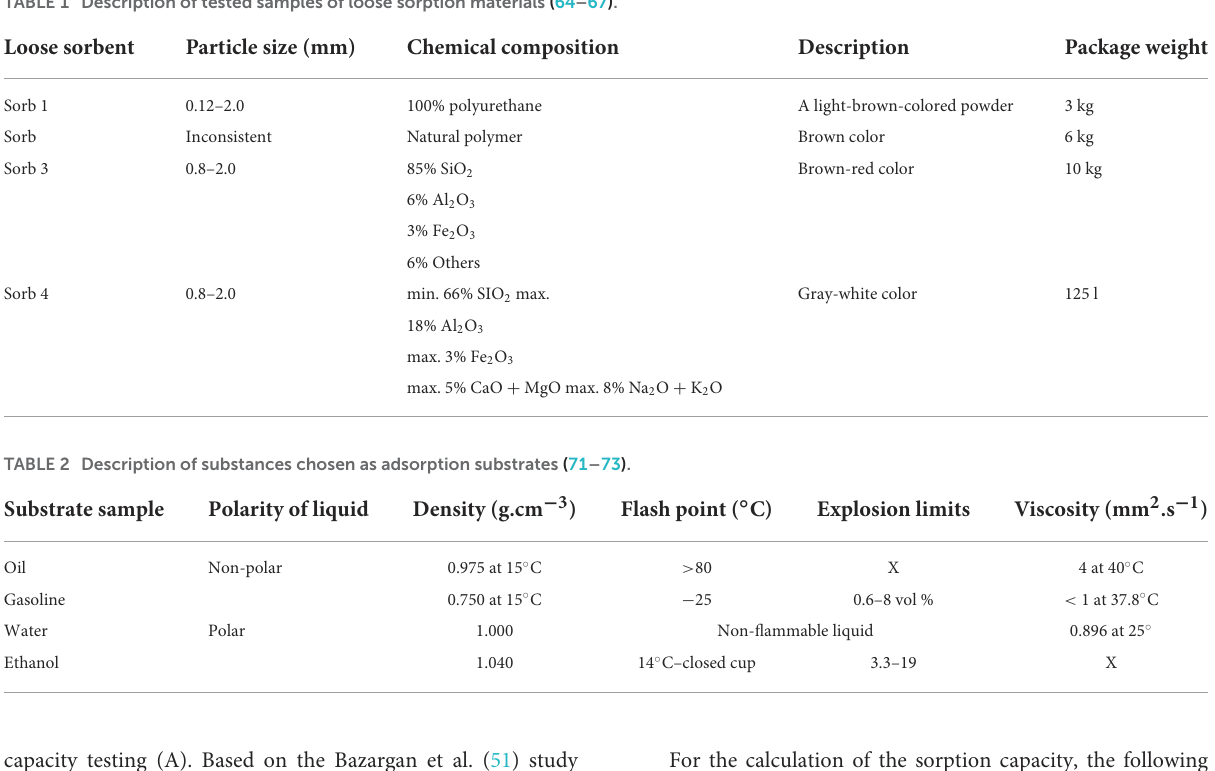
TABLE 1 Description of tested samples of loose sorption materials (64–67).